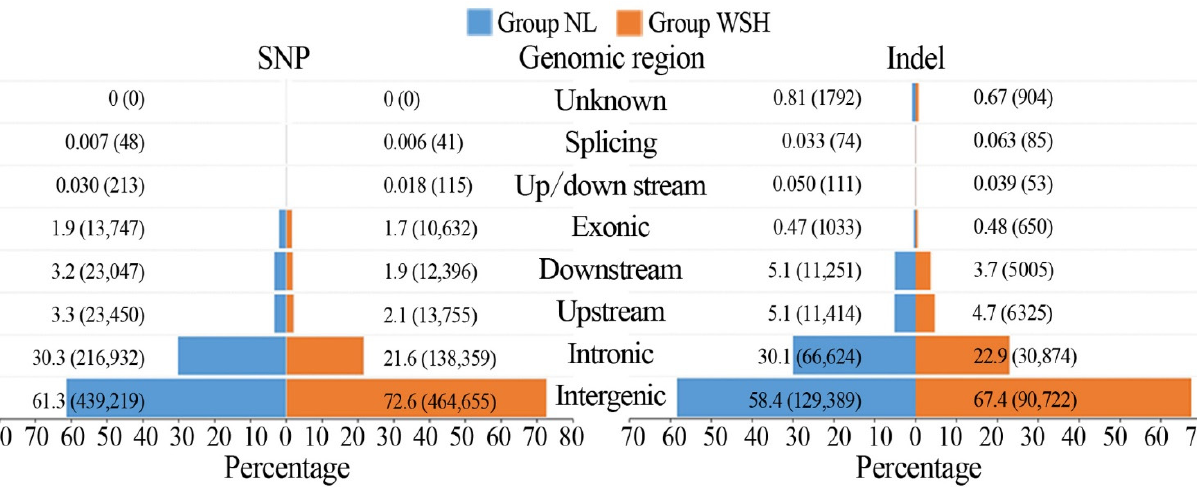
Figure 2. Distribution, proportion, and number of SNPs and Indels identified within each group. Each pair of data represented the percentage (numbers out the brackets) and the amount (numbers in the brackets), respectively.